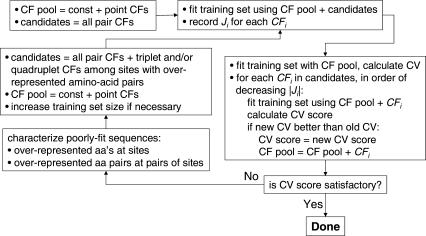
The Procedure for Fitting a Cluster ExpansionCluster functions (CFs) capture the contribution of a particular set of amino acids (aa) at a set of sites. Point, pair, and triplet CFs contain the contributions of amino acids at single sites, pairs of sites, triplets of sites, etc. The energetic contribution of any cluster function CFi is denoted by the variable Ji. CV score designates the cross-validation root mean square error (i.e., the average error with which the energy of each sequence is predicted when left out of the fit), and its behavior serves as a measure of parameter significance. The goal of the fitting procedure is to find an optimal pool of CFs with which to expand the energy. Point and constant (const) CFs are always included and thus form an initial pool of CFs. In the next step, all pair CFs are considered as candidates. In order to asses the relative importance of candidate CFs, they are initially all added into the fit and their corresponding Ji's are stored. The candidates are then visited one by one in the order of decreasing |Ji| and considered for inclusion into the CF pool. Candidates are included if they reduce the CV score. If the final CV score upon trying all pair CFs is not satisfactory, the list of candidates is appended with higher-order terms, and the procedure is repeated. Details are provided in Materials and Methods.